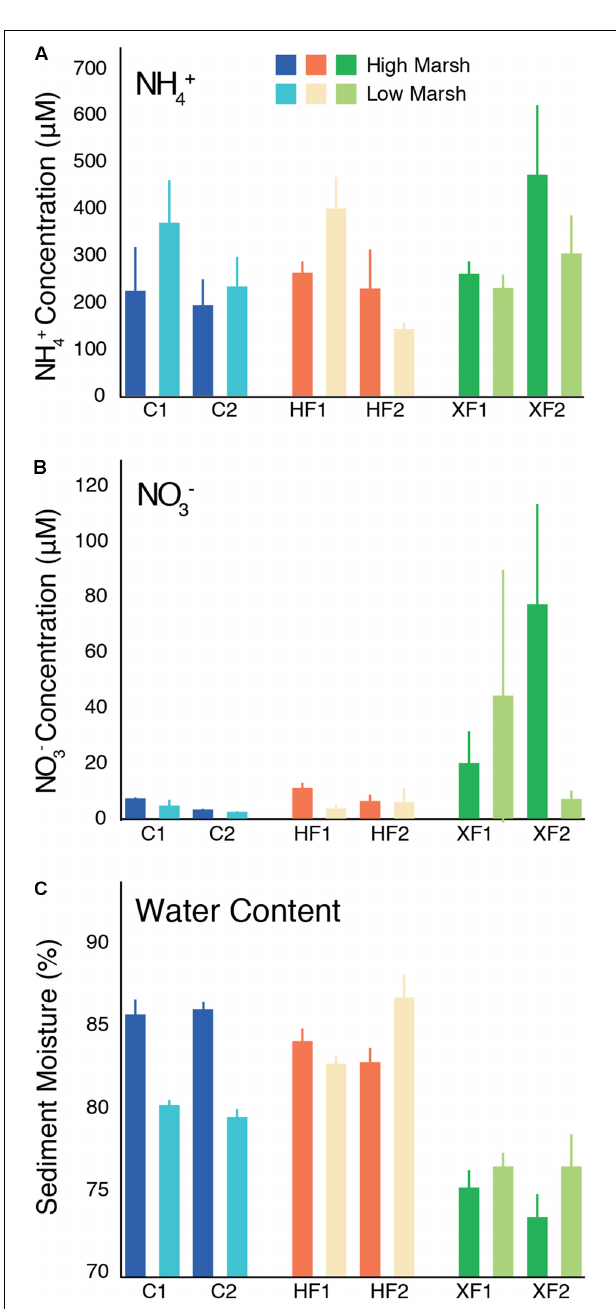
FIGURE 1 | Environmental data from sediments collected from the high and low marsh habitats of two replicate control (C), highly fertilized (HF) and extra highly fertilized (XF) salt marsh plots. Data include (A) pore-water ammonium (NH 4 + ) concentrations ( µ M), (B) pore-water nitrate (NO 3 − ) concentrations ( µ M), and (C) sediment moisture content (%). Each bar represents the average (and range) of values from two replicate